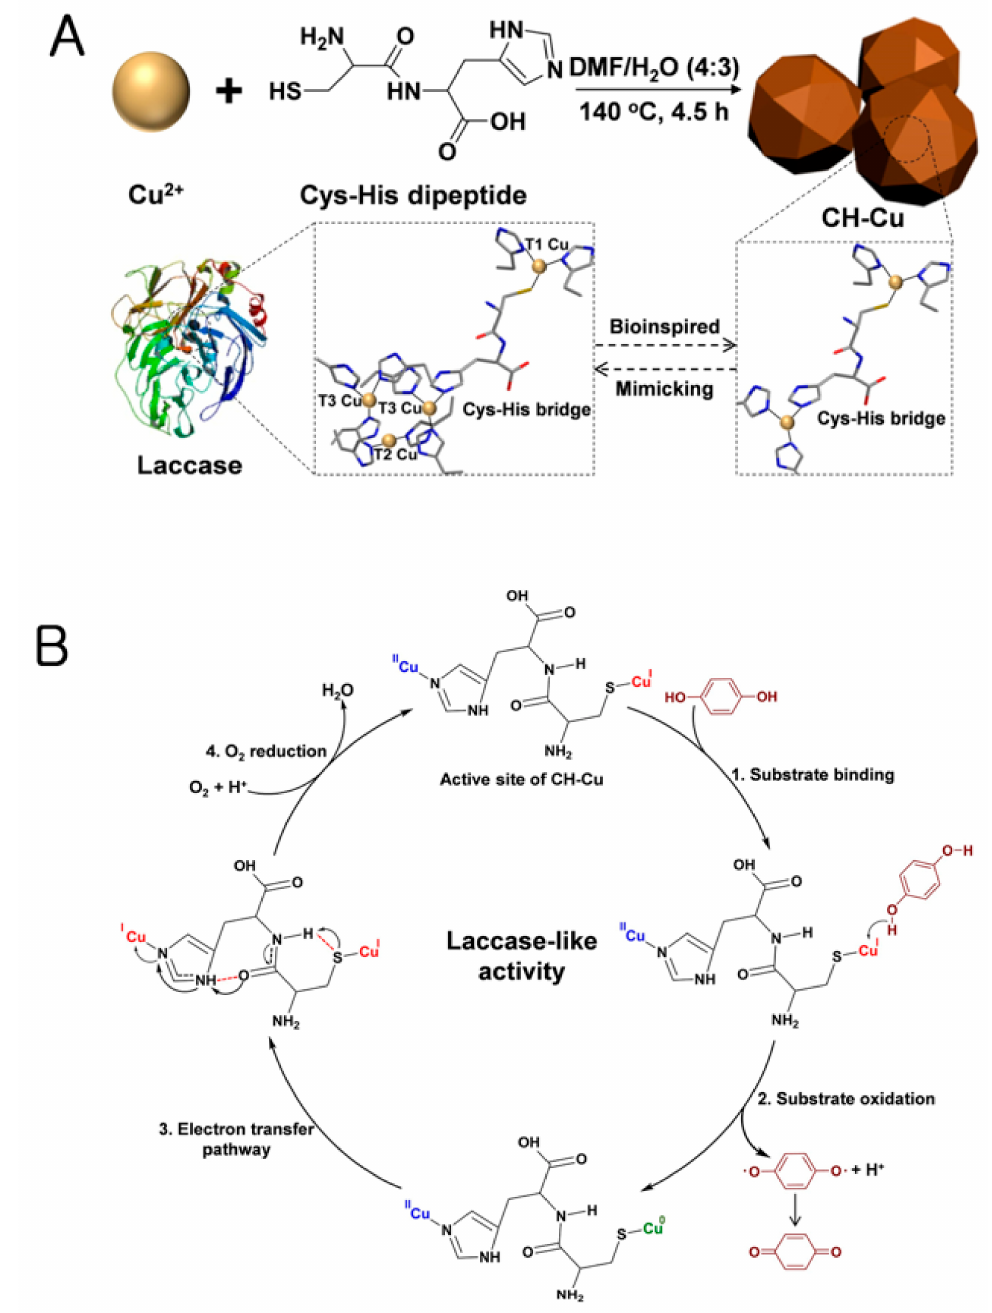
Figure 3. ( A ) Schematic illustration of the construction of laccase mimicking Cys-His (CH)- Cu nanozymes, which preserve many catalytic centers mimicking the active site of natural lac- case. ( B ) Schematic illustration of possible catalytic mechanism involving the CH-Cu nanozymes. Reprinted with permission from ref. [47]. Copyright 2019